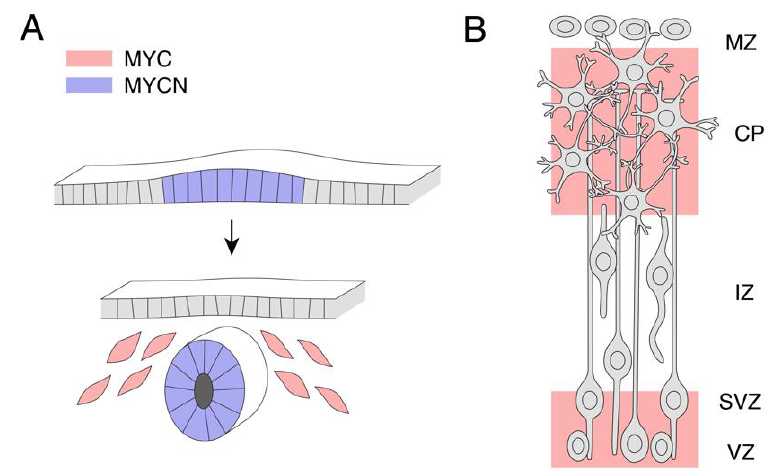
Figure 1. MYC and MYCN are highly expressed in neural precursors during mammalian development. ( A ) MYCN expression is high in the neuroectoderm and the neural tube. During the neural tube formation, MYC expression is high in the neural crest. ( B ) At later stages of development, the cortex is layered into distinct zones. VZ, ventricular zone, SVZ, subventricular zone, IZ, intermediate zone, CP, cortical plate, MZ, medullary zone. MYC protein expression was observed in VZ, SVZ and CP.